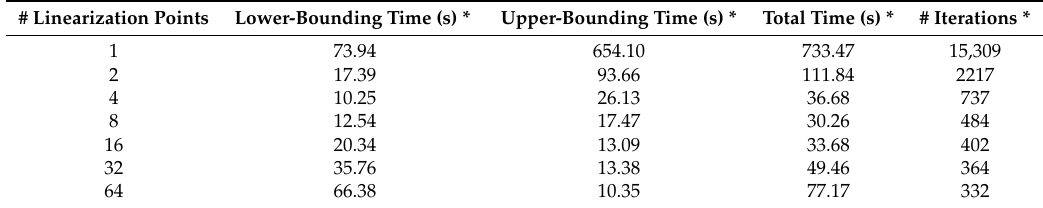
Table 2. The impact of the number of linearization points ( 1 + | B W | ) on our implementation’s branch-and-bound solution time for (9).